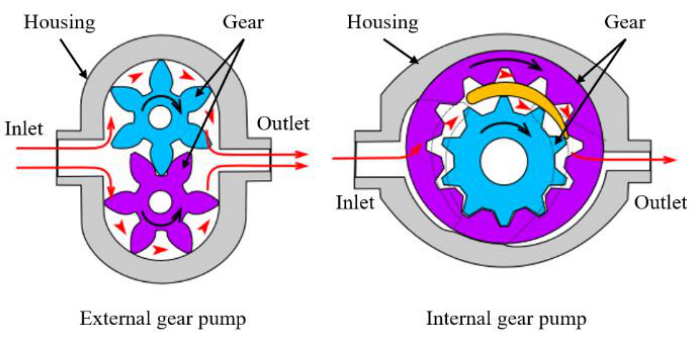
Figure 1. Operating mode of gear pump (from [23]).